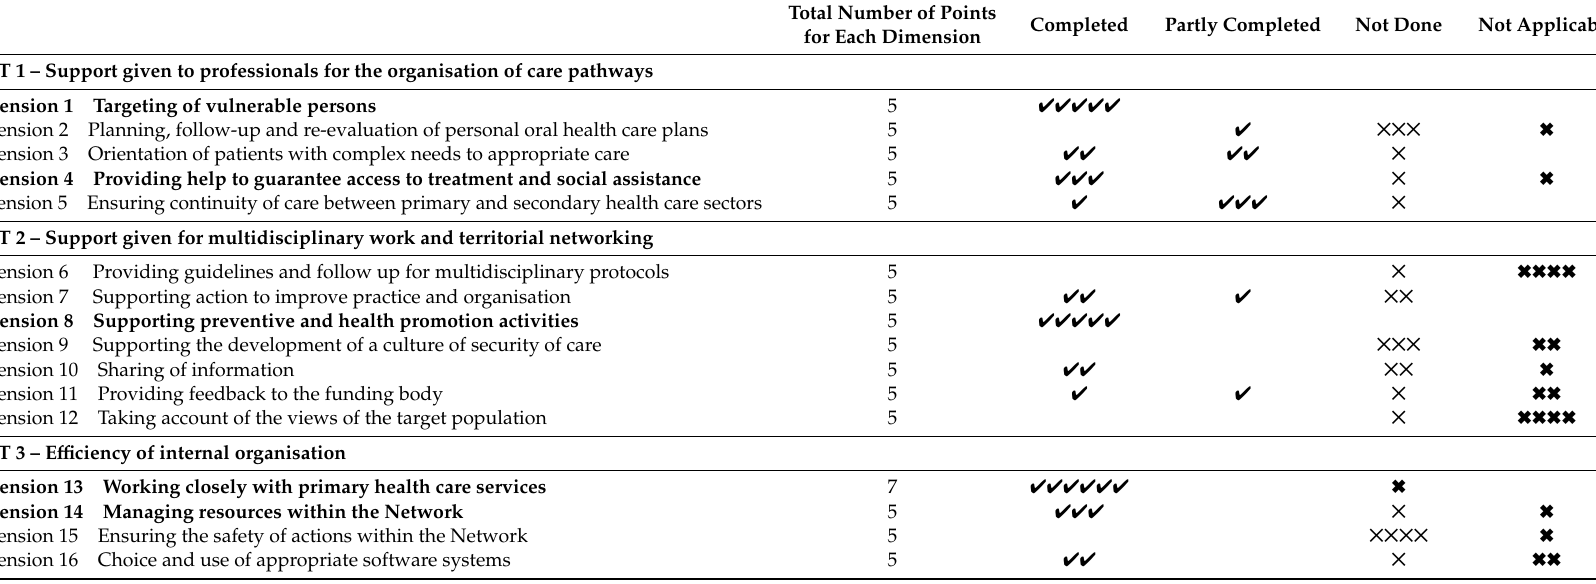
Table 1. Points achieved in each dimension of the internal evaluation of the R é seau Sant é Bucco-Dentaire et Handicap de la region Rh ô ne-Alpes (RSBDH) defined by